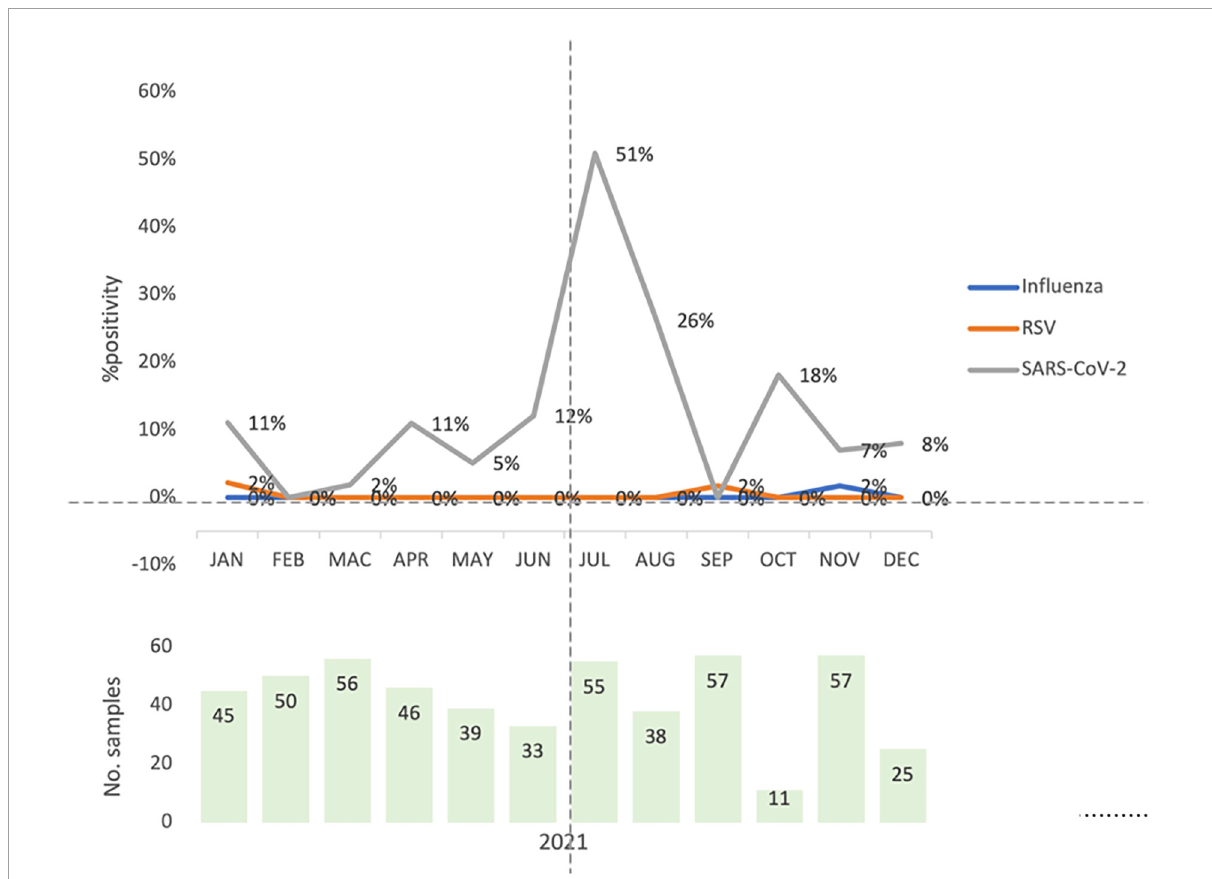
FIGURE2 Total monthly virus detection rates for influenza, respiratory syncytial virus and severe acute respiratory syndrome coronavirus-2 for all four study sites. The overall monthly percentage positivity rates for influenza virus (influenza, blue), respiratory syncytial virus (RSV, orange) and the severe acute respiratory syndrome coronavirus-2 (SARS-CoV-2, gray) are shown cumulatively for all four study sites for the surveillance study. The light green bars represent the total number of samples obtained for each month.